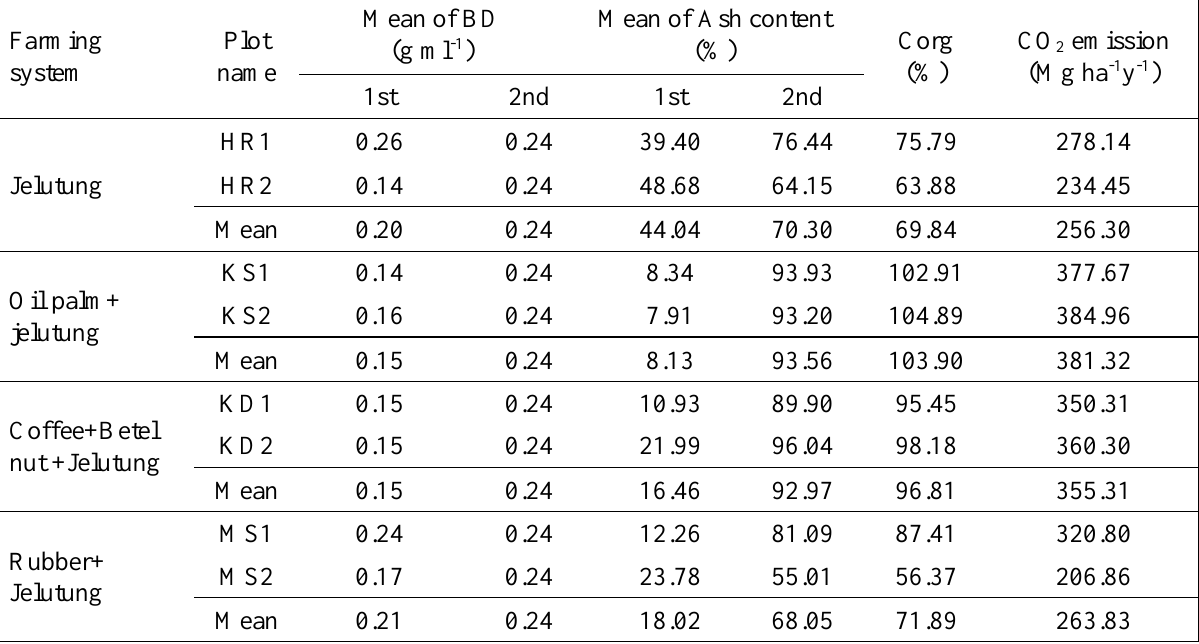
Table 4. Change of ash content, bulk density, and estimation of CO (jelutung demo-plots) in Tanjabar, Jambi in the depth range 0–10 cm. The first measurement was on 2 January 2014 and the second measurement was on 8 December